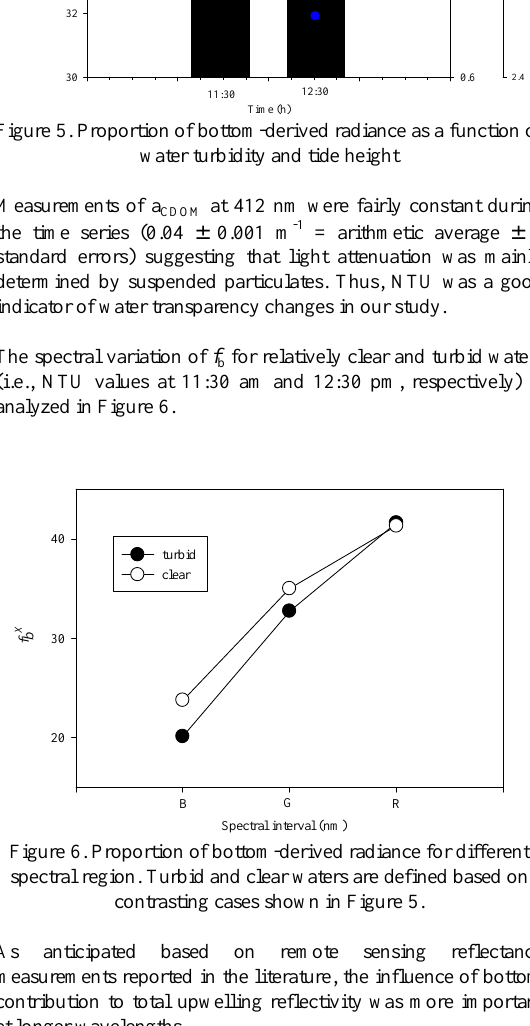
Figure 7. The calculation of f bRGB throughout the whole area was simplified by using the same dp values obtained in the vicinity of the lagoon-lander